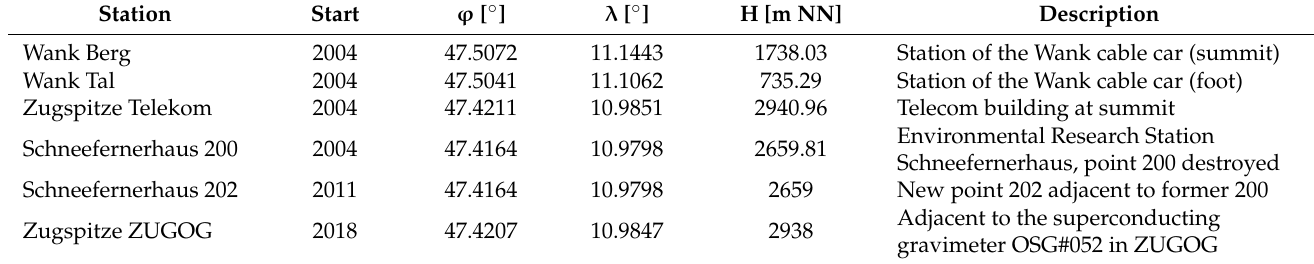
Table 2. Coordinates (WGS1984) of the absolute gravity sites occupied by the Hannover FG5-220.